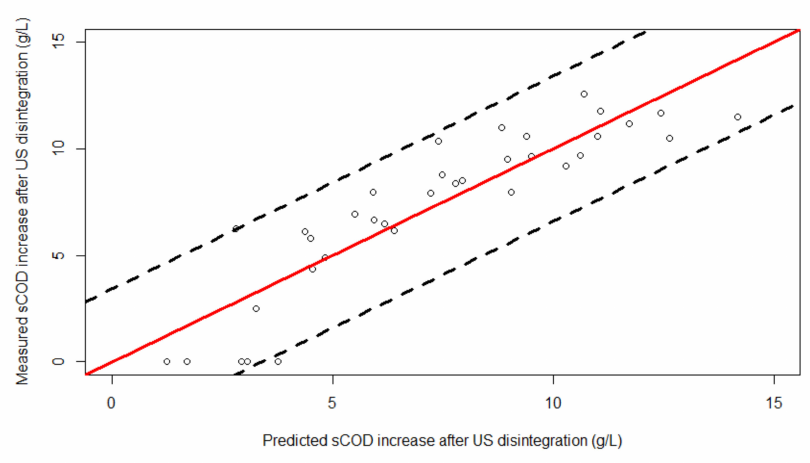
Figure 6. The predicted and measured sCOD increase after US disintegration. The red line has an angle of 45 ◦ ; the dotted lines are the 95% confidence interval.